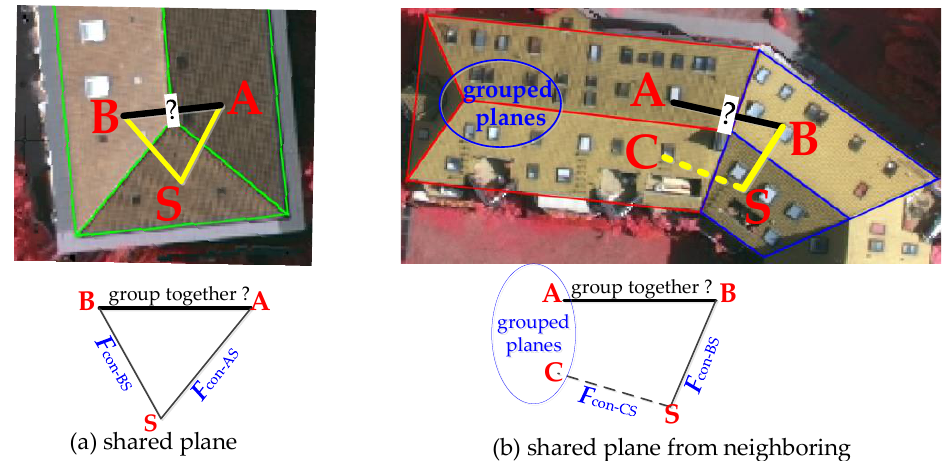
Figure 4. Illustration of consistency constraint to group plane A and B . The F Con-AS and F Con-BS are 3D concave/convex relationships (similarity constraint) for adjacent planes.